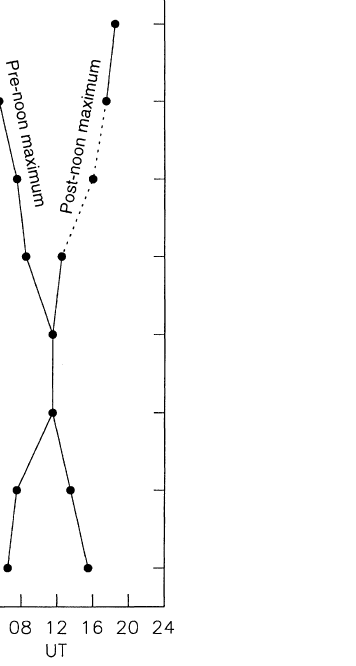
Fig. 9. The monthly variation in the times of maxima in the occurrence of ionospheric backscatter observed with the Finland radar. The post-noon maximum for October 1995 is very broad and hence the centre is